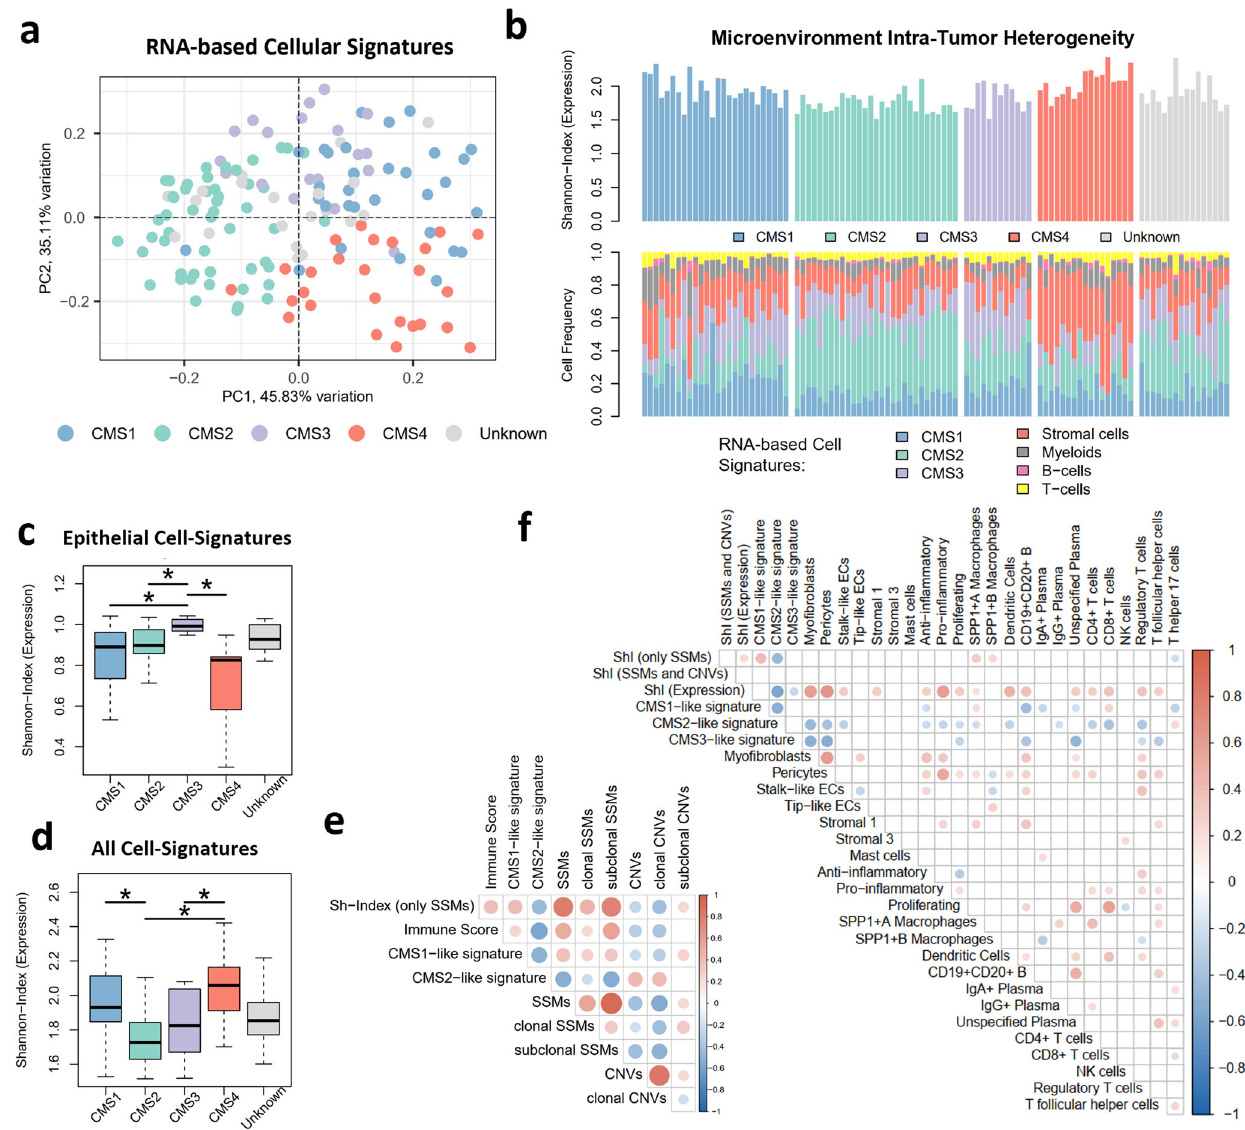
Fig. 3 Microenvironment Inter- and Intra-Tumor Heterogeneity of CRC. a Principal Component Analysis of cell frequencies from RNA-based deconvolution approach. CRC samples are colored according to CMS subtype. b Microenvironment composition of CRC samples grouped by CMS subtype, showing the microenvironmental Shannon-Index and cell frequency for RNA-based signatures of: epithelial cells (where CMS1, CMS2, CMS3-like are individually represented); stromal cells; myeloids; B-cells and T-cells. c , d Distribution of the microenvironment Shannon-Index (based on expression signatures) segregated by CMS subtype, considering the cell-frequency of: only epithelial cells ( c ) or all cell signatures ( d ). Numbers of samples per CMS subtype: CMS1 n = 27; CMS2 n = 36; CMS3 n = 12; CMS4 n = 19; Unknown n = 18. e Heatmap of Spearman correlation coef fi cient between: